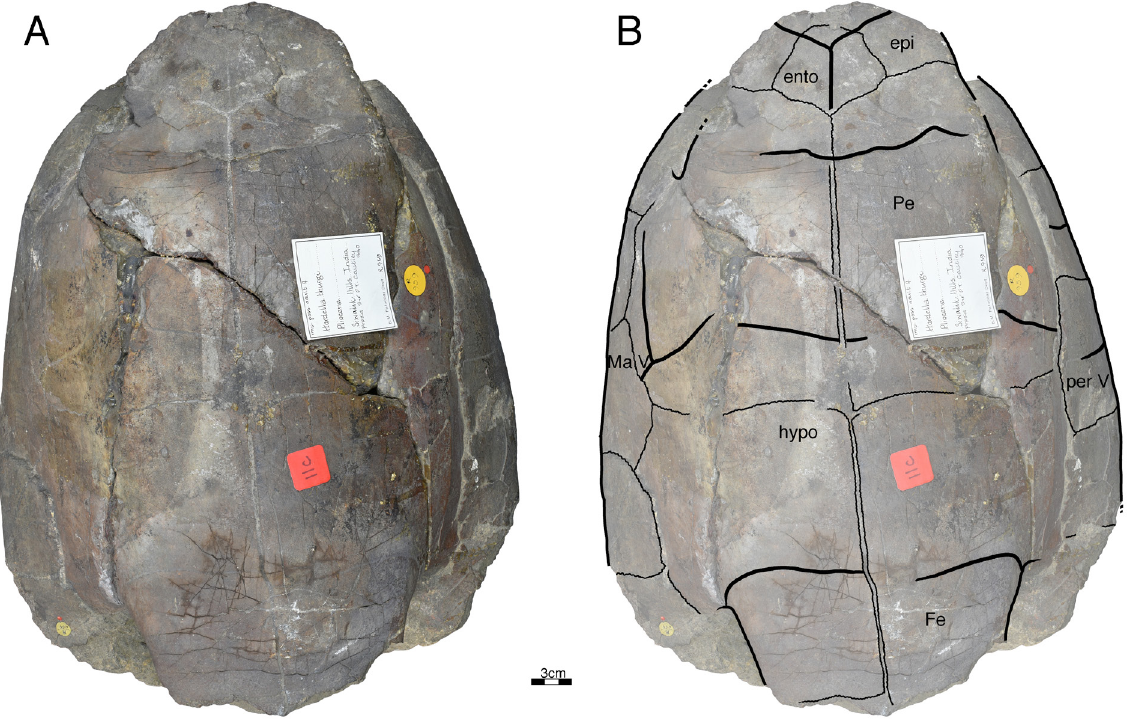
Fig. 7. BMNH R.959, referred to Hardella thurgi (Gray, 1831) by Lydekker (1889b), here identified as Palatochelydia indet. A . Photograph of plastron. B . Illustration of plastron. Scale bar: